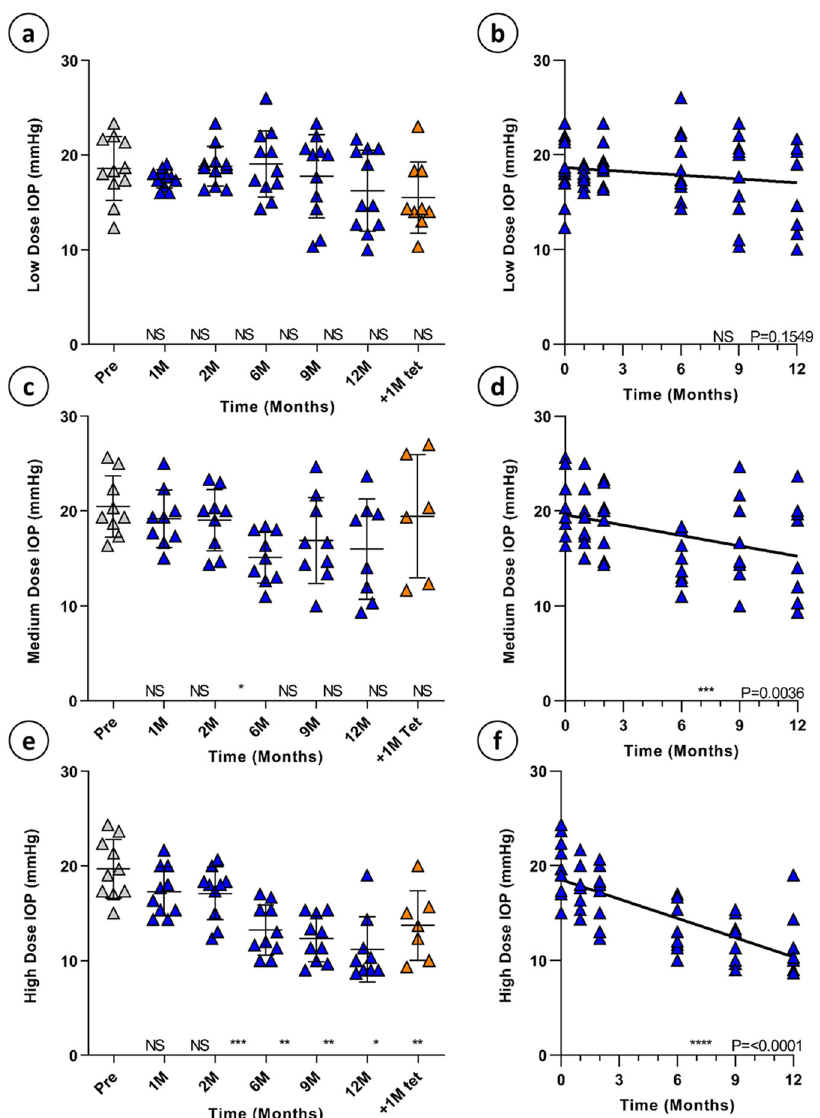
Fig. 2 Transgene expression ’ s effect on intraocular pressure. A dose dependent reduction in IOP was found between groups: low, medium, and high dose animals showed a reduction of 12.6%, 21.87%, and 43.2% at 12 months respectively ( a , c , and e ) that was maintained over 12 months ( b ; simple linear regression, p = 0.1549, N = 11 d ; p = 0.0036, N = 9 and f ; p < 0.0001, N = 10, Error bars = SD). At 12 months, animals were administered 5% w/w tetracycline diet and IOP increased by 21.5% and 22.5% in medium and high dose animals respectively after 1 month ( c and e